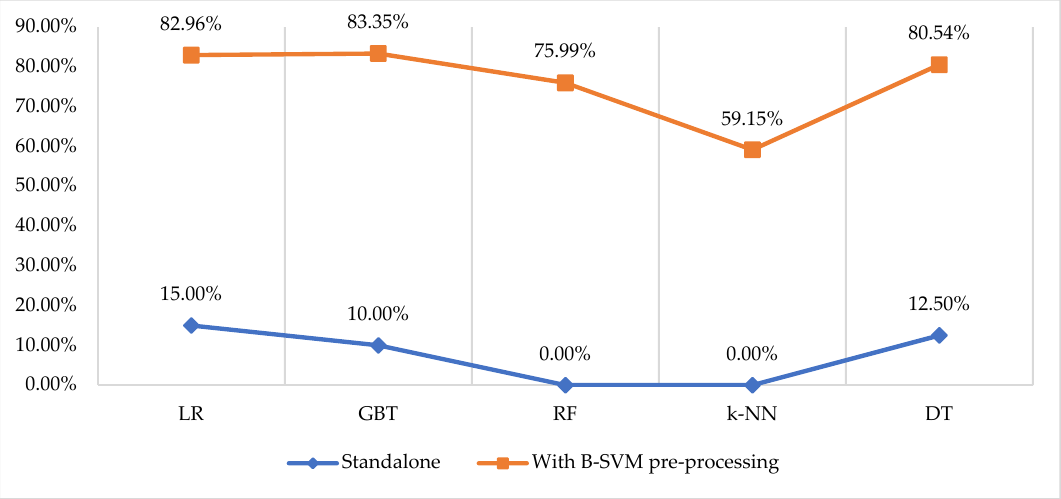
Figure 2. Sensitivity level before and after data pre-processing.